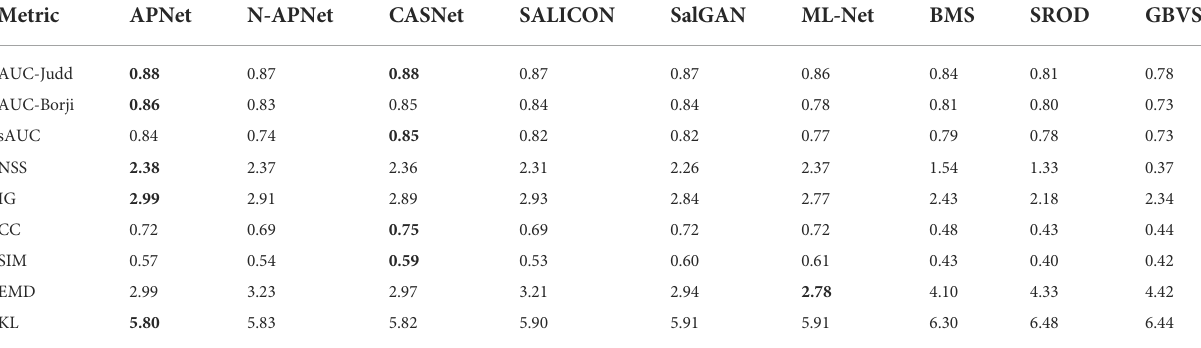
TABLE 5 Quantitative results on OSIE dataset. The best performance in each metric is highlighted in bold.